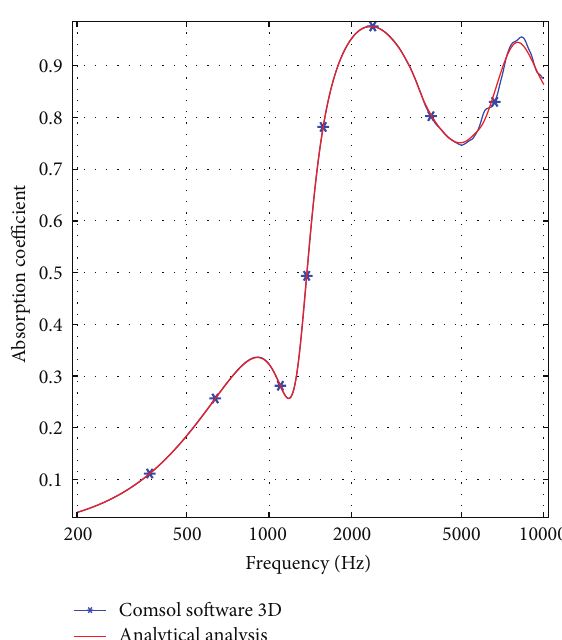
Figure 3: Absorption coefficient of polyurethane